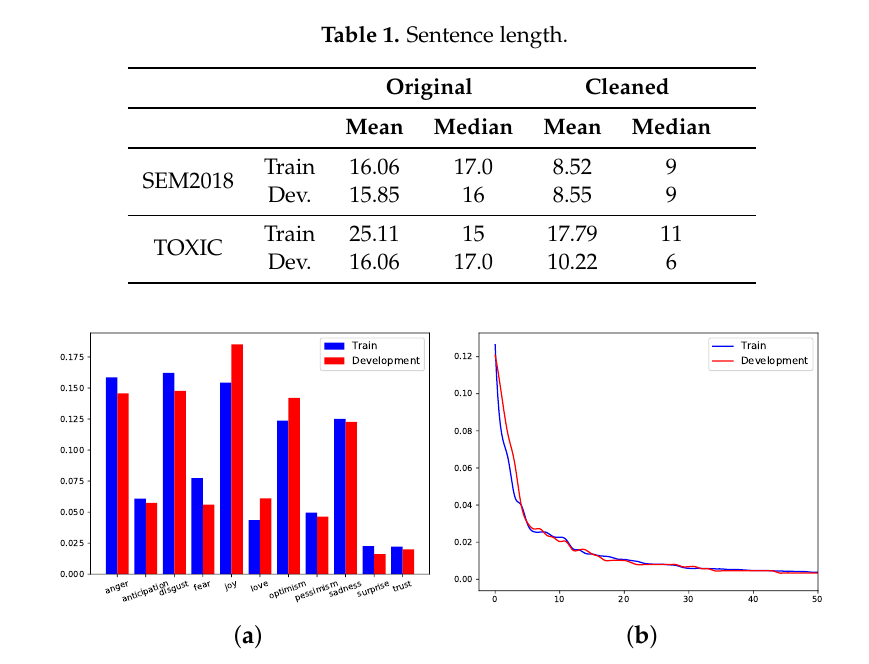
Figure 8. SEM20118 Class Distribution ( a ) and frequency of unique class combinations ( b